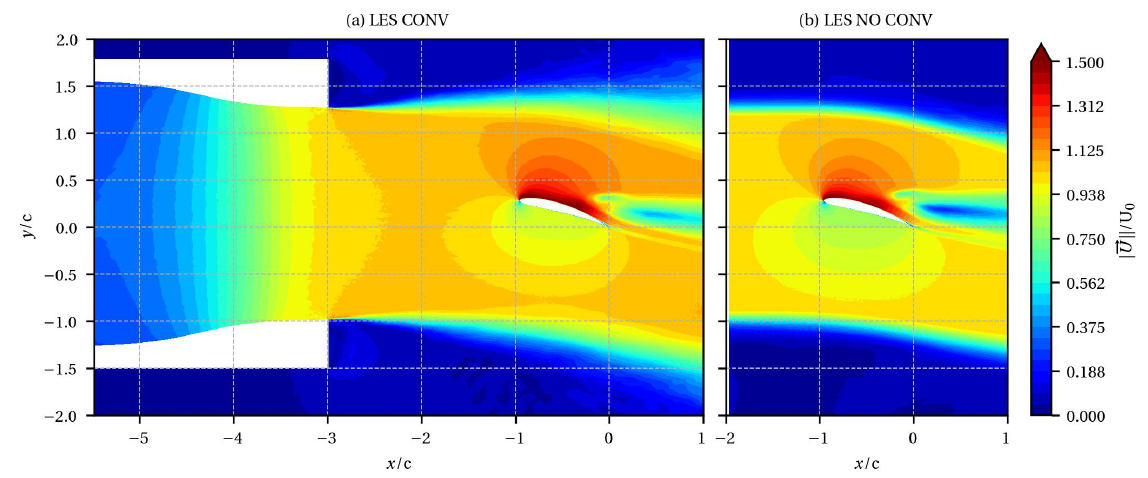
Figure 5. Mean velocity magnitude fields with ( a ) and without ( b ) the convergent at z /c =